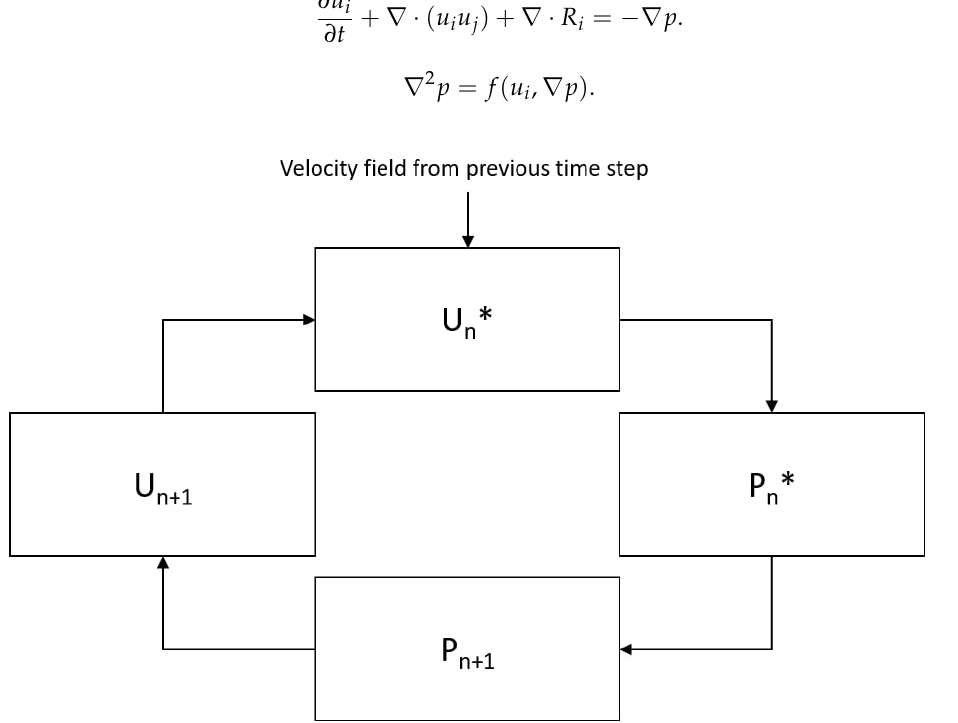
Figure 3. Scheme of one iteration of PimpleFoam performed and repeated until the reaching of the convergence criteria. U n ∗ and P n ∗ are, respectively, the estimate of the velocity matrix and pressure matrix. P n + 1 and U n + 1 are the corrected pressure and velocity fields at iteration